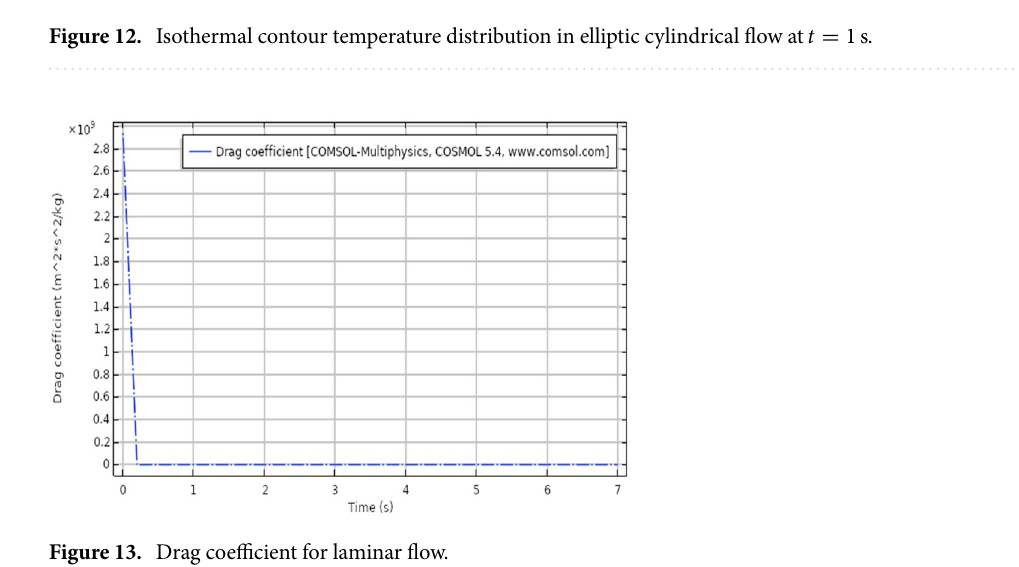
Figure 13. Drag coefficient for laminar flow.